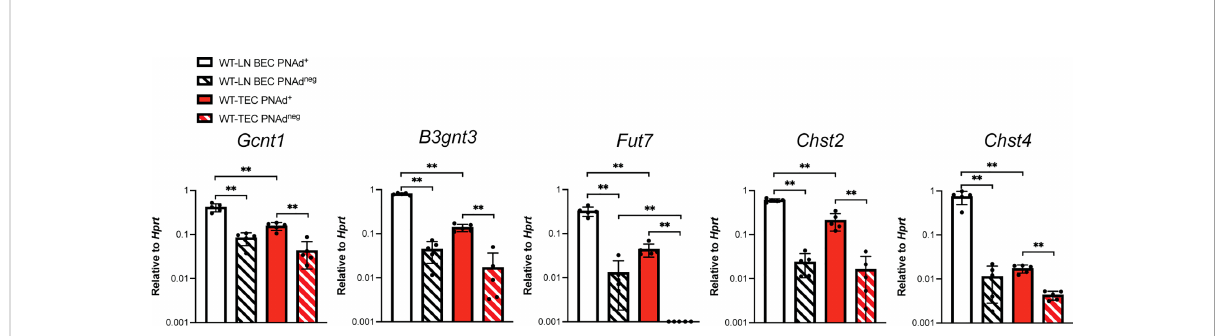
FIGURE 3 Glycosyl transferases are expressed at signi fi cantly lower levels in PNAd + TEC than in LN PNAd + BEC. C57BL/6 mice were I.P. injected with B16- OVA cells and tumors were harvested 14 days after implantation. LN were harvested from non-tumor-bearing mice. Endothelial cells were sorted from CD45+ depleted LN and I.P. tumor suspensions, and the expression levels of indicated RNA transcripts were determined by quantitative PCR (qPCR), as described in Methods. Data from one experiment presented as 2 - D CT relative to Hprt, n=5 LN or I.P. tumors per group. Results are mean ± SD analyzed by unpaired Welch ’ s t-test.